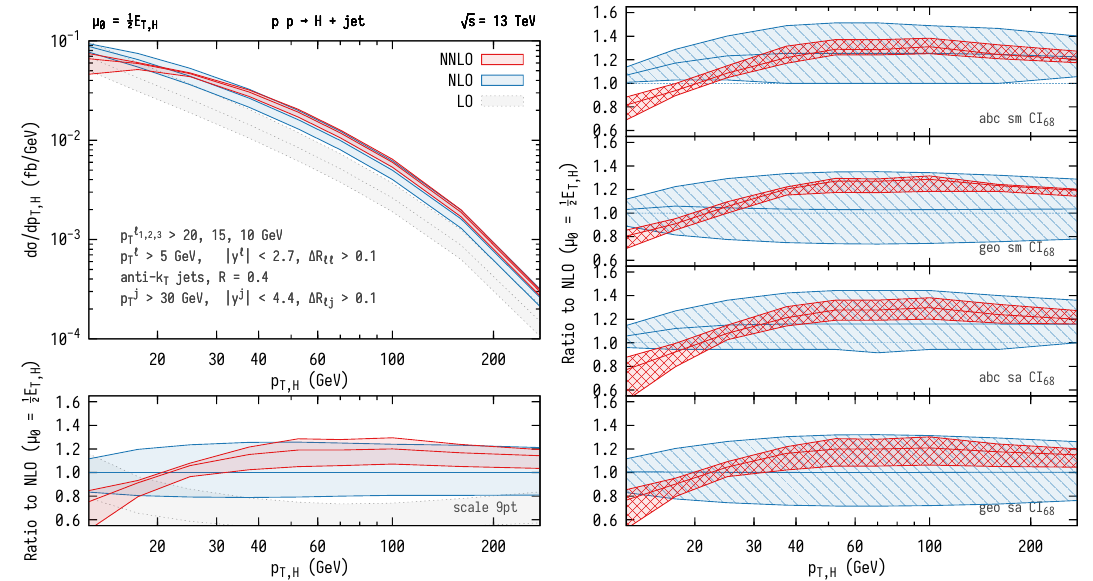
Figure 21 . Higgs+jet production up to NNLO with µ 0 = 1 absolute dσ/dp distributions and 9-point scale variation envelopes normalised to the NLO pre- T,H diction at µ . Right: 68% CIs for the abc and geometric models using the scale-marginalisation (top) 0 and scale-averaging (bottom) prescriptions (also normalised to